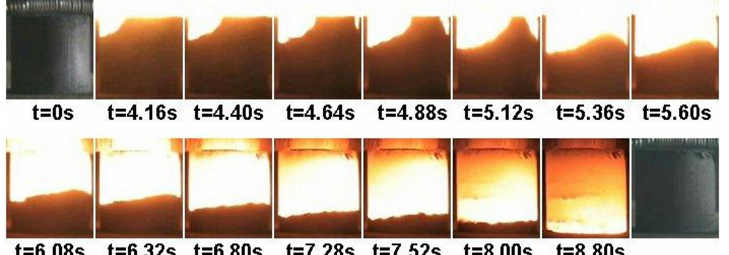
Figure 2. Recorded typical, distinct and representative combustion images of the powder compacts with the nominal composition of (Mo Ti )Si (3 # ). 0.7 0.3 2